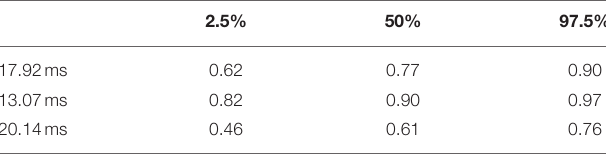
TABLE 3 | 95% confidence intervals for PTT respiratory swing sensitivity at three thresholds (training data).